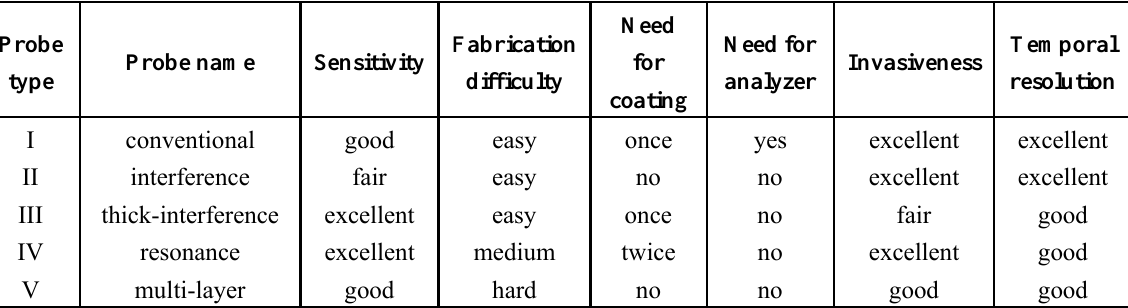
Table 1. Comparison of the five probe